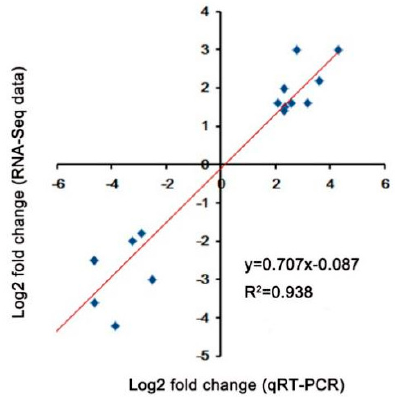
Figure 3. Validation of DEGs under heat stress. Correlation between the fold change analyzed by RNA-seq ( y -axis) and data obtained using qRT-PCR ( x -axis).